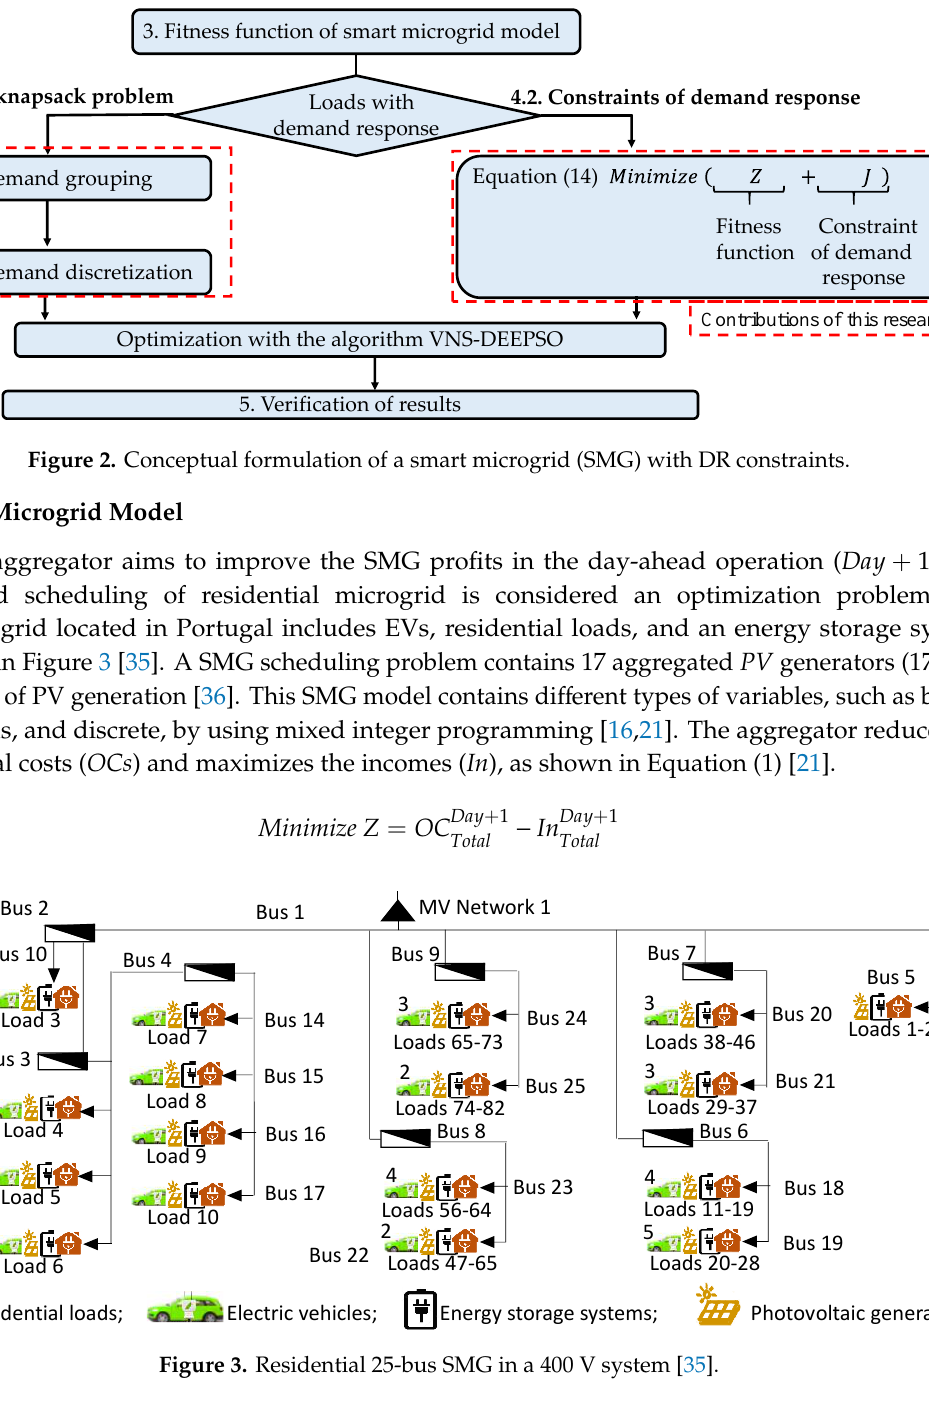
Figure 1. Algorithm flowchart: ( a ) variable neighborhood search (VNS); ( b ) differential evolutionary